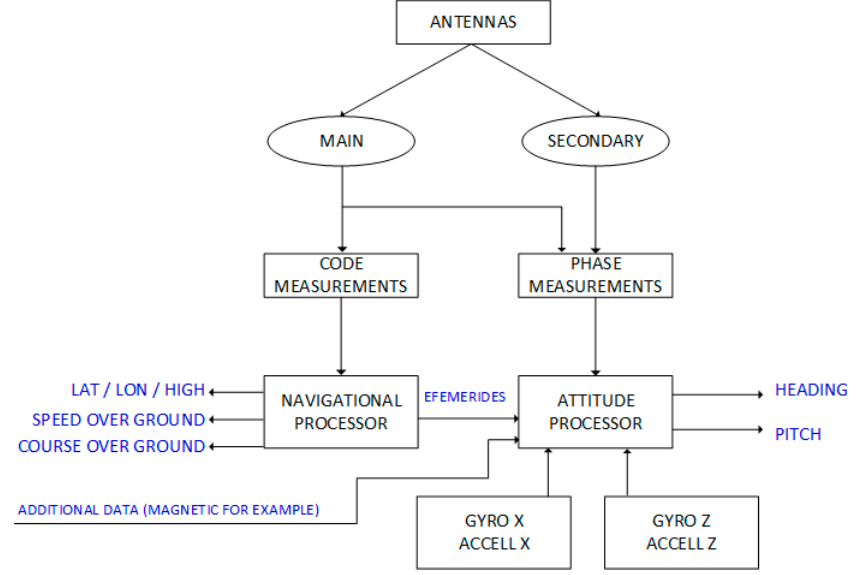
Figure 3. Possible block-diagram of a standard satellite compass. (Source: A.Felski)